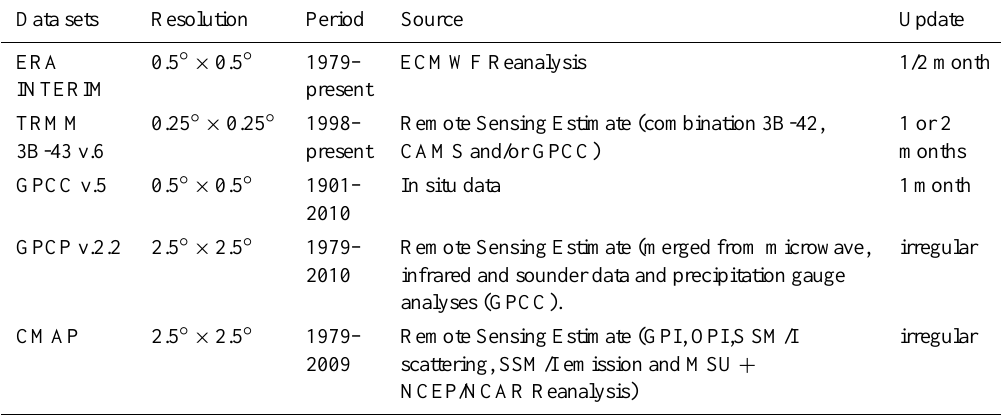
Table 2. Description of global data sets available in near-real-time that could be used for monitoring precipitation conditions at continental